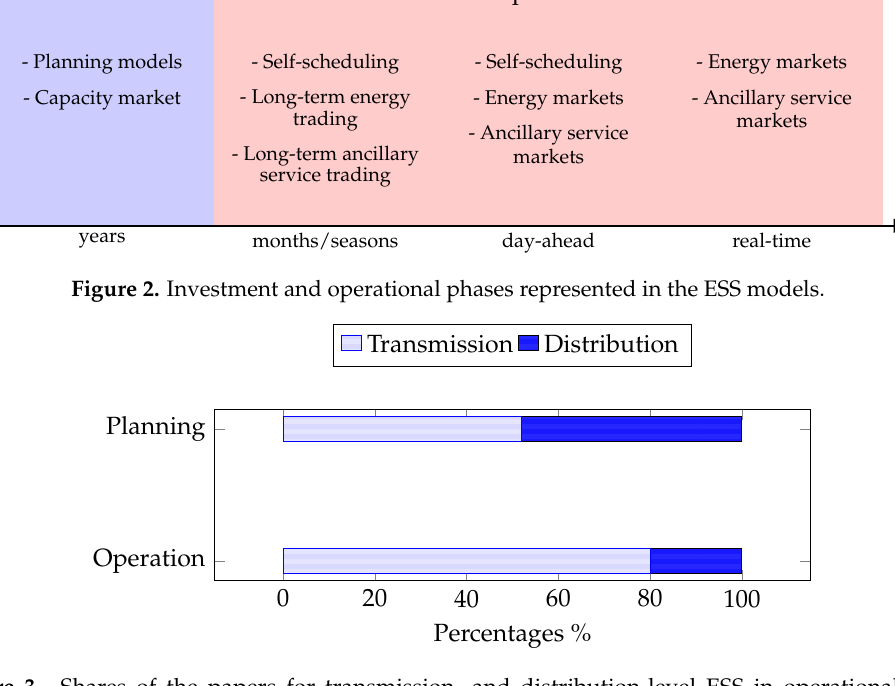
Figure 3. Shares of the papers for transmission- and distribution-level ESS in operational and investment